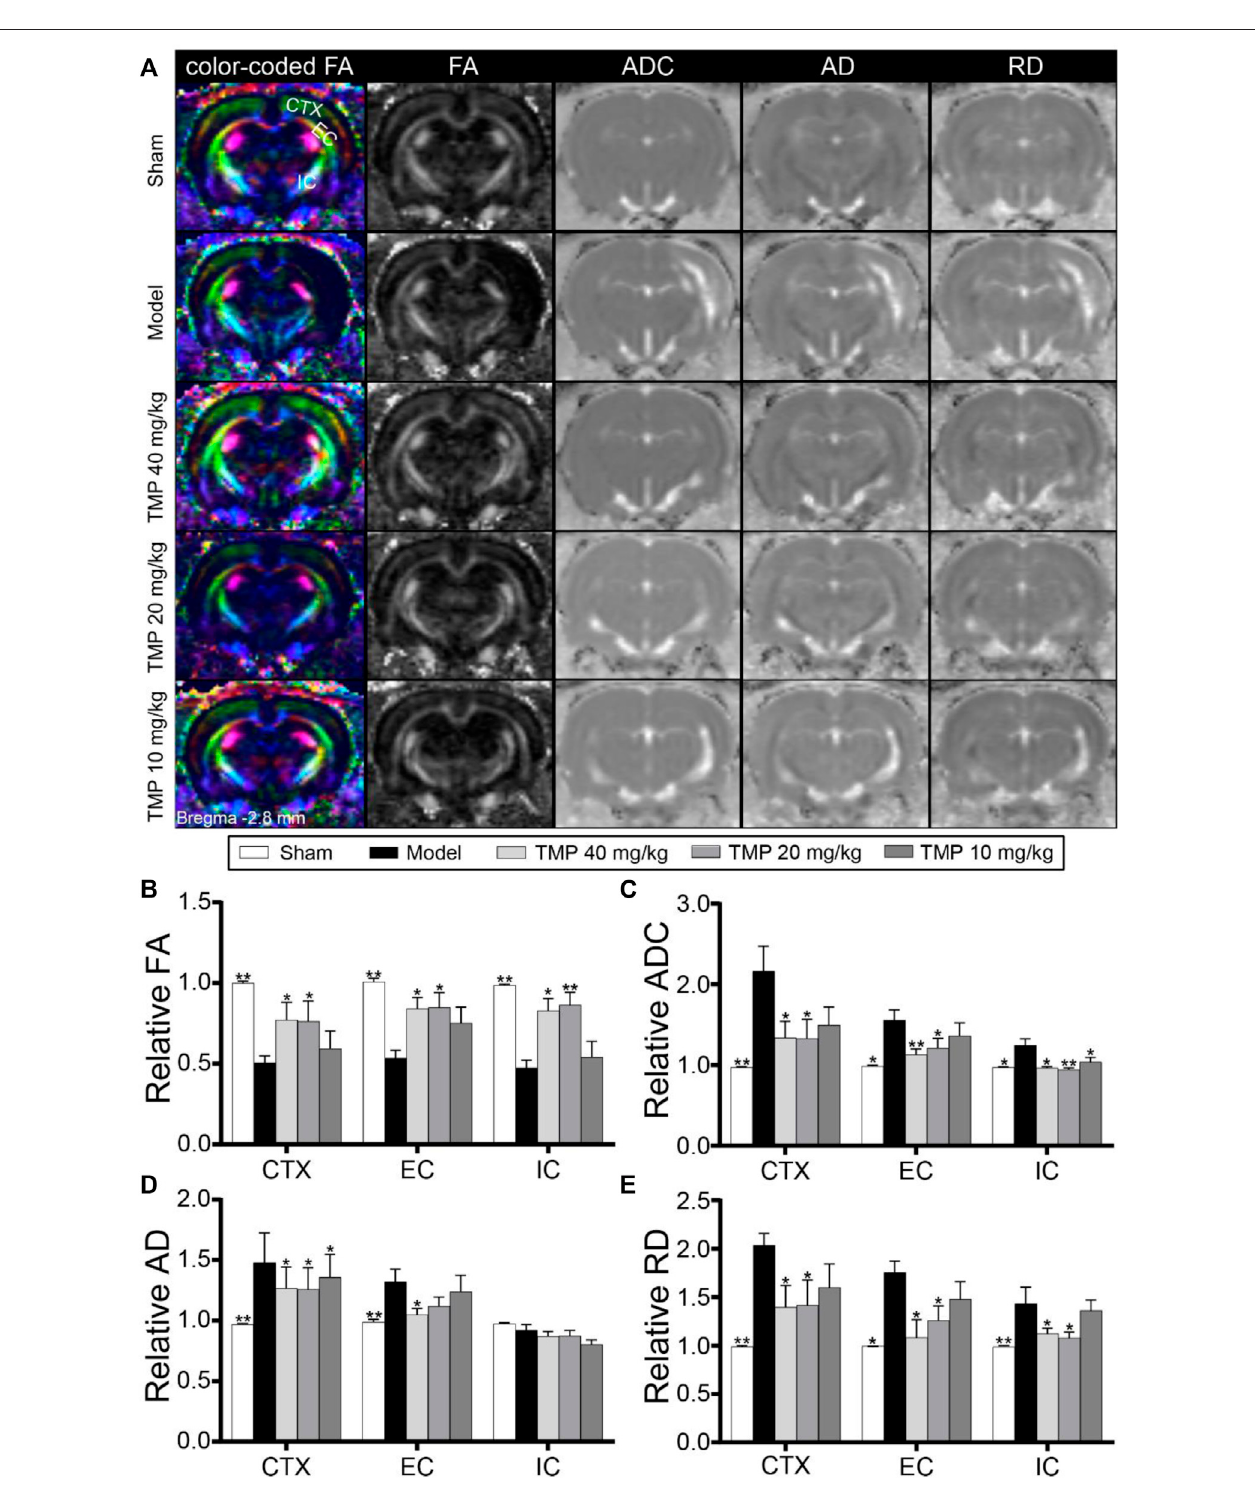
FIGURE 3 | Effect of TMP on the axonal microstructure in MCAO rats. (A) Typical axial color-coded FA, FA, ADC, AD, and RD images of each group. ROIs of the peri-infarct cortex (CTX), external capsule (EC), and internal capsule (IC) were identi fi ed on the color-coded FA images in the sham group ( n = 6). (B – E) Quantitative analysis of the relative FA, ADC, AD, and RD of CTX, EC, and IC, respectively. * p < 0.05 and ** p < 0.01 vs. Model group.